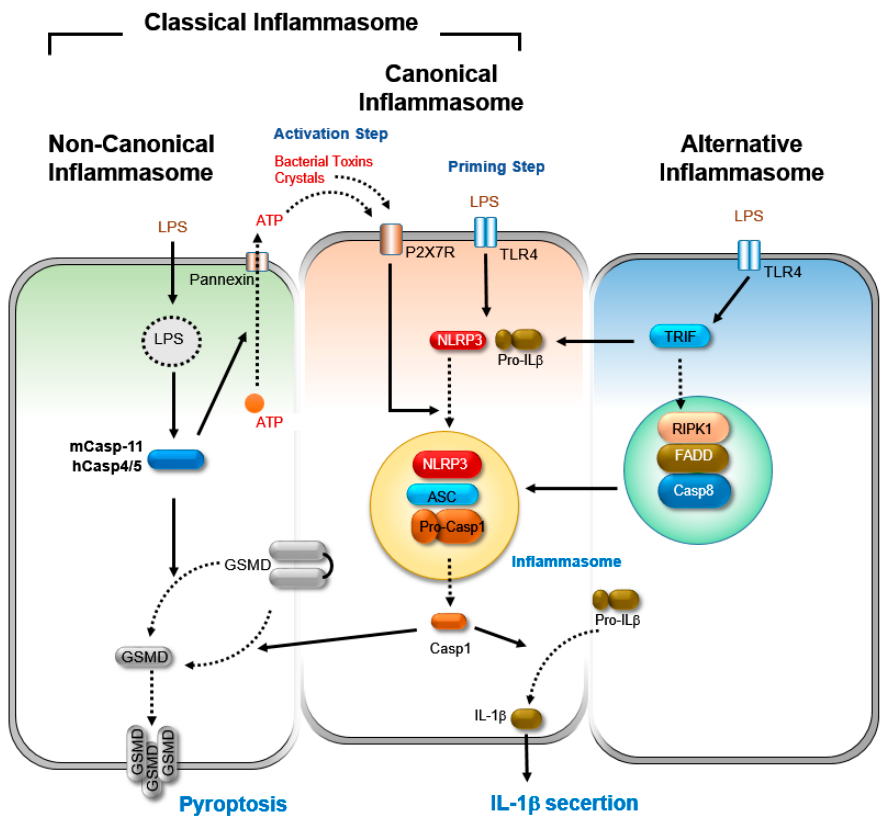
Figure 1. A simple depiction of signaling pathways for the activation of classical NLRP3 inflammasome (canonical and non-canonical) and alternative inflammasome. Canonical inflammasome activation includes a priming and activation step. The priming step, by pathogen-associated molecular patterns (PAMPs) and cytokines, leads to the expression of inflammasome components, NLRP3, and pro-IL-1 β through the NF- κ B pathway. The activation step is triggered by damage-associated molecular patterns (DAMPs), such as ATP, crystals, pore-forming toxins, and metabolites, which induce the formation of the NLRP3 inflammasome complex, where caspase-1 is activated. Activated caspase-1 in turn cleaves pro-IL-1 β for the production and secretion of active IL-1 β . It also cleaves gasdermin D (GSMD), which leads to the formation of membrane pores and triggers pyroptosis. Non-canonical NLRP3-inflammasome is initiated by sensing cytosolic LPS by caspase-11 / -4 / -5. Then, activated caspase-11 / -5 / -4 cleaves GSDMD, which leads to pyroptosis. In parallel, the activated caspase-11 / -4 / -5 activates pannexin-1, leading to ATP release and K + e ffl ux in order to derive NLRP3 inflammasome activation and IL-1 β secretion. In contrast to classical inflammasome activation, alternative inflammasome activation can be triggered by a single signal. LPS stimulation induces the of the potassium e ffl ux. The alternative inflammasome activation does not induce